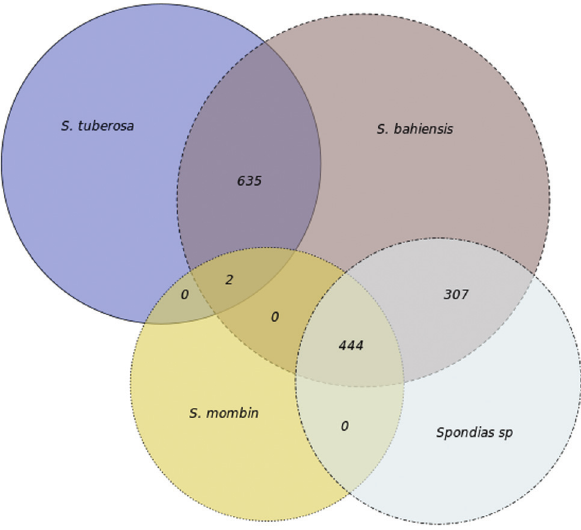
Figure 3 - Venn diagram of the allelic distribution of Spondias bahiensis . The Venn diagram shows the number of alleles that are shared among Spondias bahiensis , Spondias tuberosa , and Spondias mombin